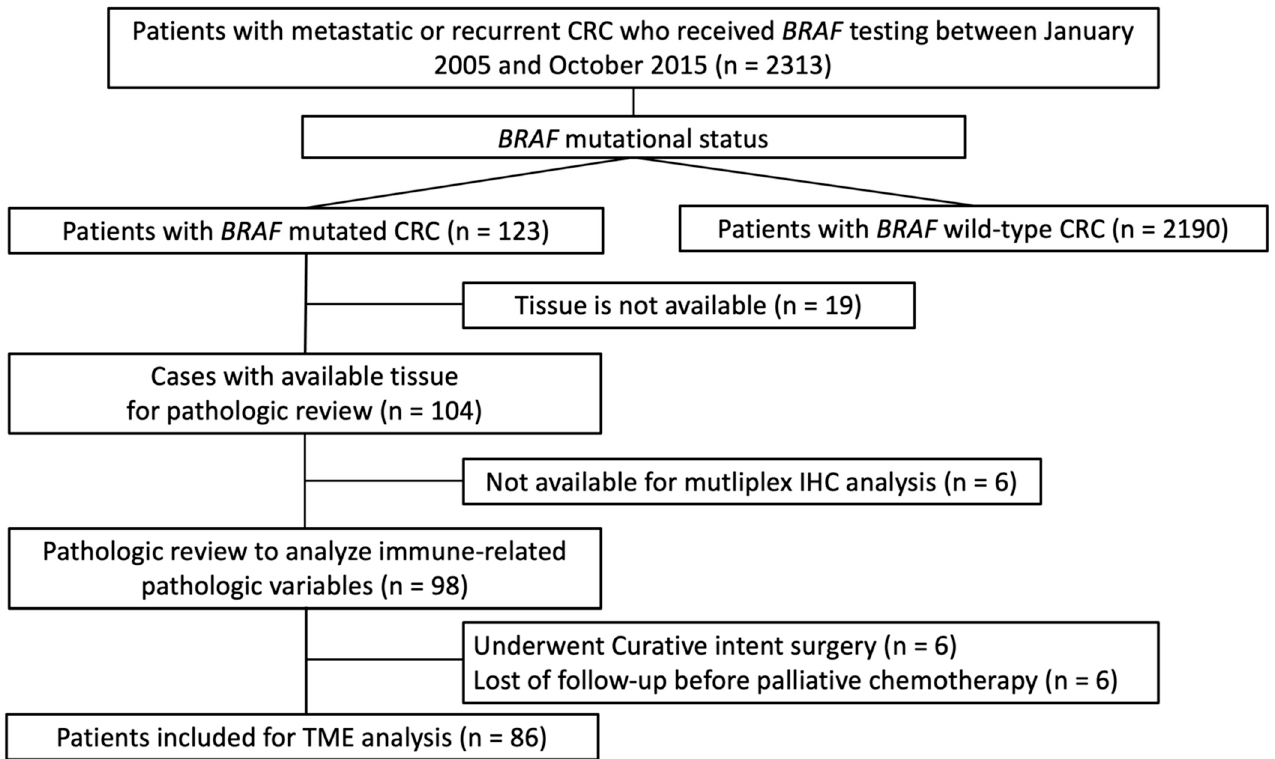
Figure 1. Flowchart of patient selection.